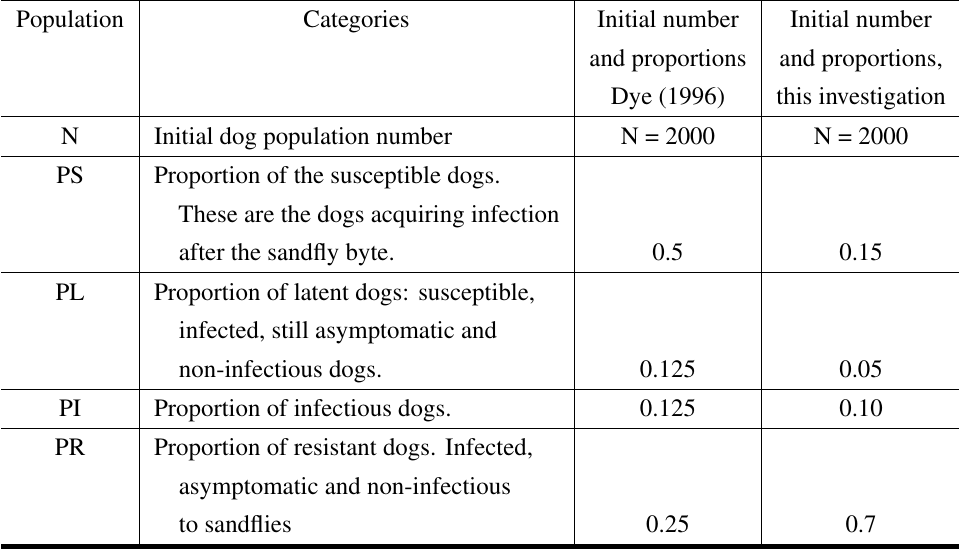
Population composition in the mathematical model for